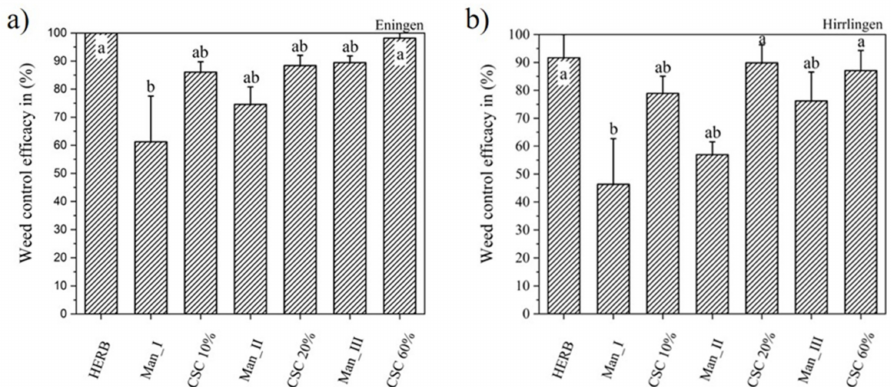
Figure 3. Percentage of weed control efficacy in spring oats in Eningen, p = 9.489 × 10 − 16 ( a ) and winter wheat in Hirrlingen p = 2.064 × 10 − 5 ( b ) in 2020. The measurement was done directly after treatment, only the herbicide treatment was measured 14 days after application. Means with the same letter were not significantly different according to the HSD-test at α ≤ 0.05. HERB = herbicide application, conventional intensity (Man_) I, II, and III = tine angle 10 ◦ , 40 ◦ , and 70 ◦ ; Crop soil cover (CSC) 10, 20, and 60% = plant burial by 10, 20, and 70% soil. The error bars show the standard deviation.